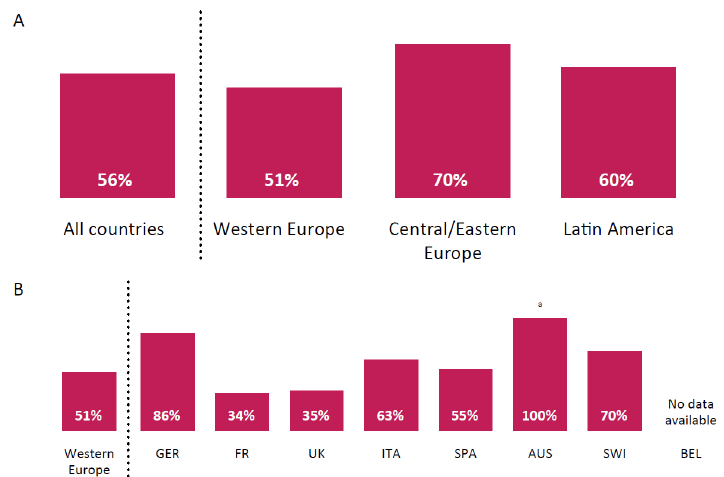
Figure 1. Percentage of physicians who consider tumor sidedness when making treatment deci- sions for patients with KRAS wildtype across ( A ) different regions and ( B ) Western Europe. AUS = Austria; BEL = Belgium; FR = France; GER = Germany; ITA = Italy; SPA = Spain; SWI = Switzerland; UK = United Kingdom. a Small sample size, so caution should be taken when interpreting these data. Schemes follow the same formatting.